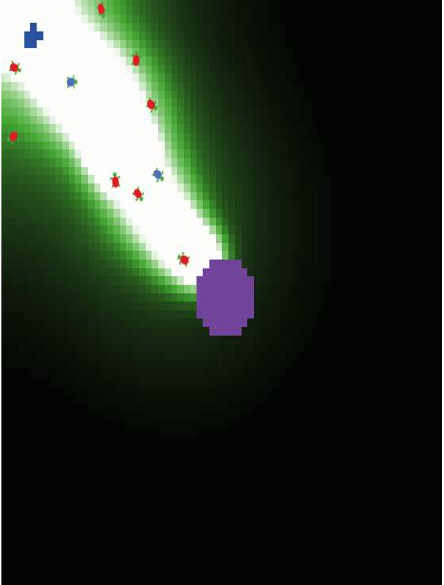
Figure 6 : Module Collection and Recruitment. Figure 7: Remaining Modules (Current